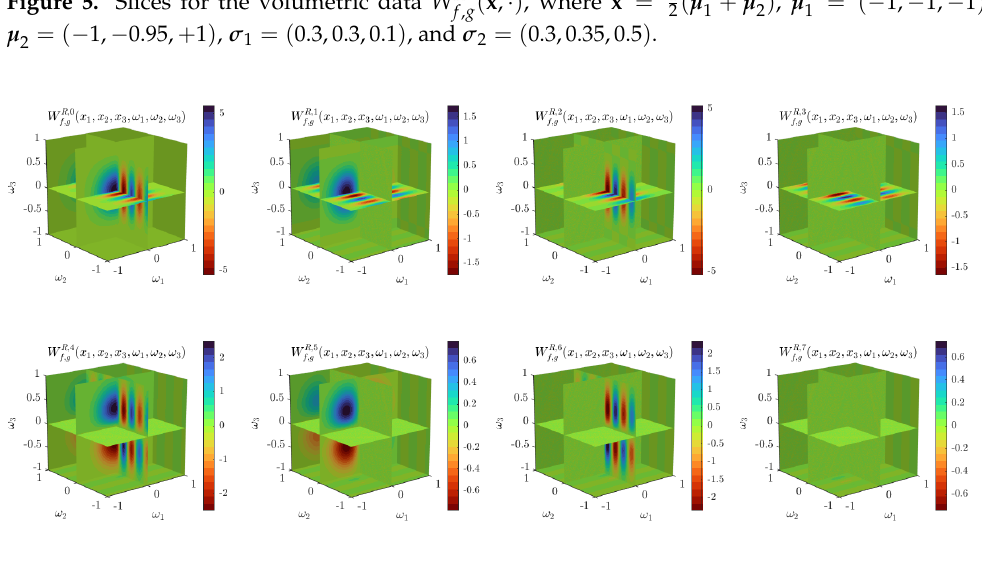
( x , · ) , where x = 1 f , g = ( 0.35,0.5,0.25 ) 2